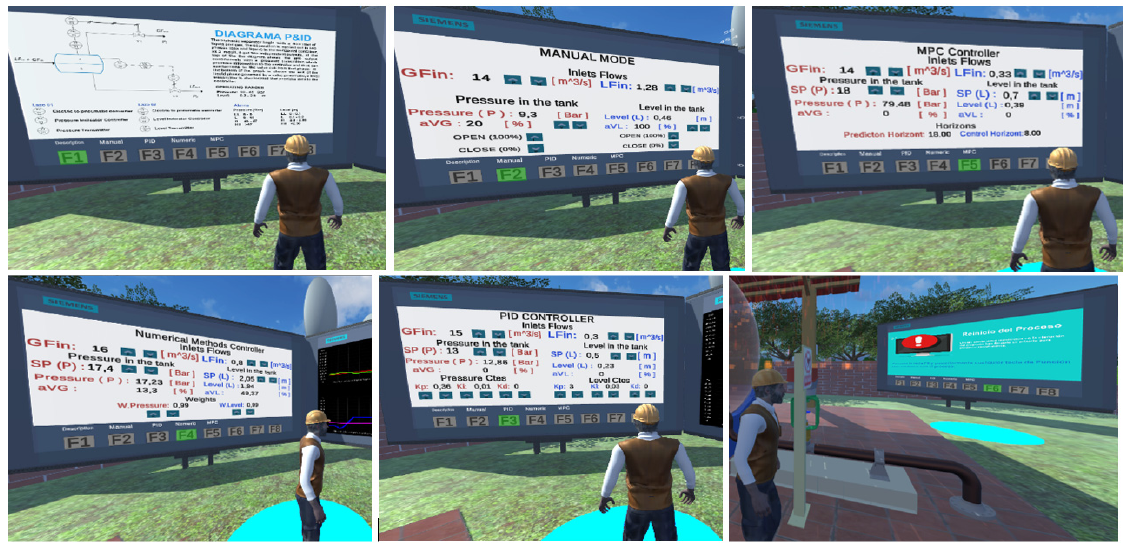
Figure 9. Interaction with screens and function keys.